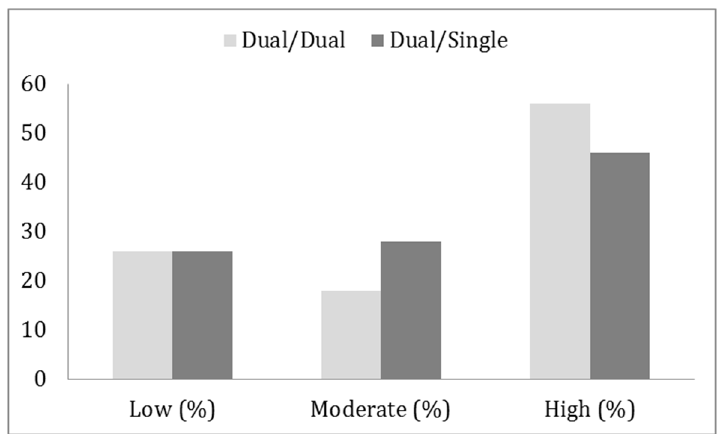
Figure 4. Responder confidence (low, moderate or high) according to type of imaging analysis.